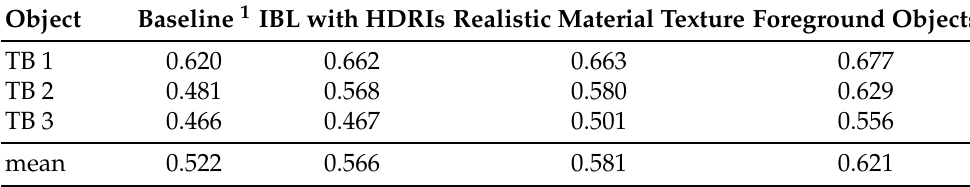
Figure 13. In addition to the previously studied TB 1, TB 2 and TB 3 are added as new test objects. Table 8. Sequential ablation study on test data with new objects ( AP [ 0.5:0.95 ]